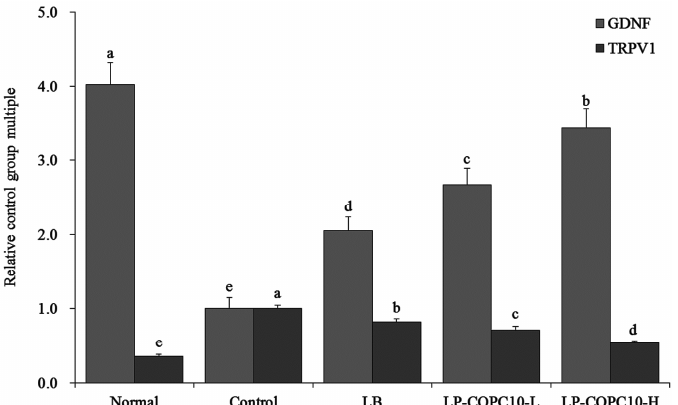
Figure 6. mRNA expression levels of TRPV1 and GDNF in the small-intestine tissue of mice. Values presented are the mean ± standard deviation. a–e Mean values with different letters in the same bars are significantly different ( p < 0.05) according to Duncan’s multiple-range test. LB: Lactobacillus bulgaricus (1.0 × 10 9 colony-forming unit (CFU)/kg body weight (bw)); LP-CQPC10-L: Lactobacillus plantarum CQPC10 (1.0 × 10 8 colony-forming unit (CFU)/kg body weight (bw)); LP-CQPC10-H: Lactobacillus plantarum CQPC10 (1.0 × 10 9 colony-forming unit (CFU)/kg body weight (bw)).